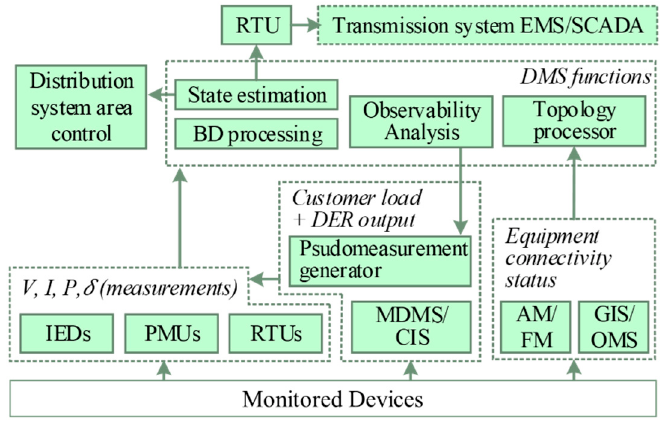
Figure 2. Data processing and system control architecture.